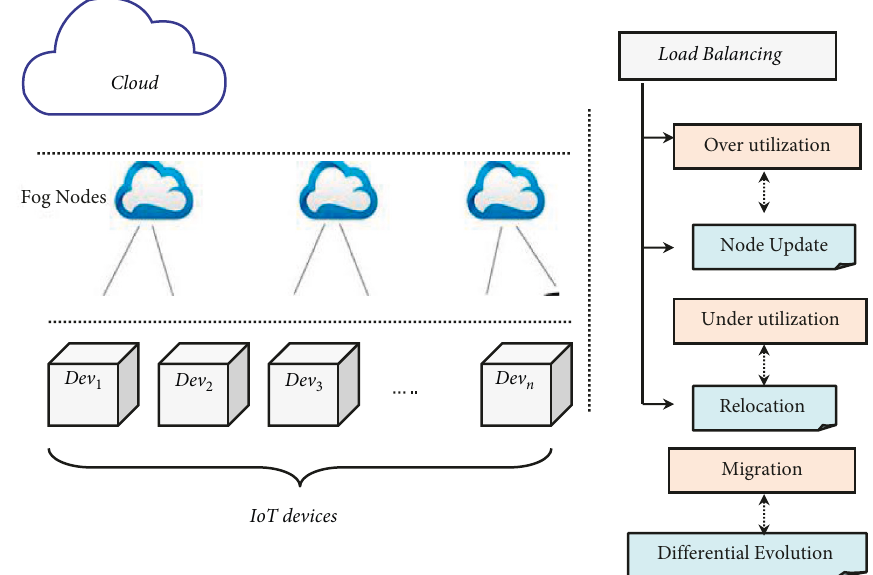
Figure 2: Block diagram of Differential Evolution-based Grey Wolf